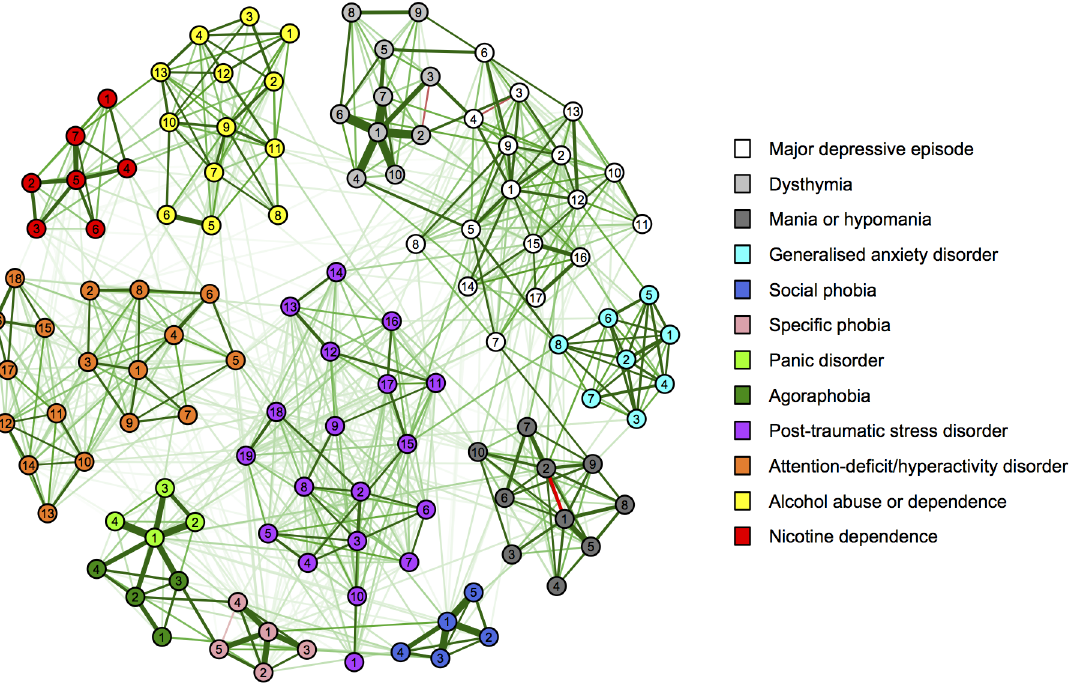
Fig 1. Empirical network of 120 psychiatric symptoms. Symptoms are represented as nodes and associations between them as edges. Node colours refer to the type of diagnosis and numbers refer to specific symptoms (see S1 Table). Green edges represent positive associations and red edges represent negative associations, while the thickness of edges represent the strength of